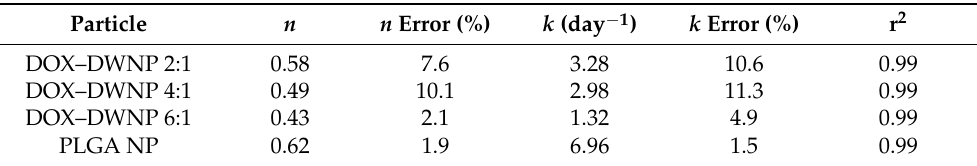
Table 1. Diffusion exponent n and constant k, according to Equation (1), of doxorubicin release from DWNPs with different PLLA/PLGA mass ratios and PLGA.